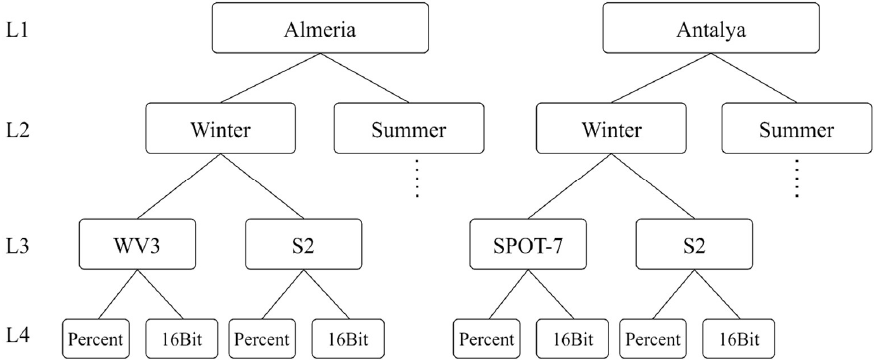
Figure 2. Simplified draft showing the factorial design made up of four factors such as L1 (study site), L2 (season), L3 (image spatial resolution), and L4 (reflectance storage scale).